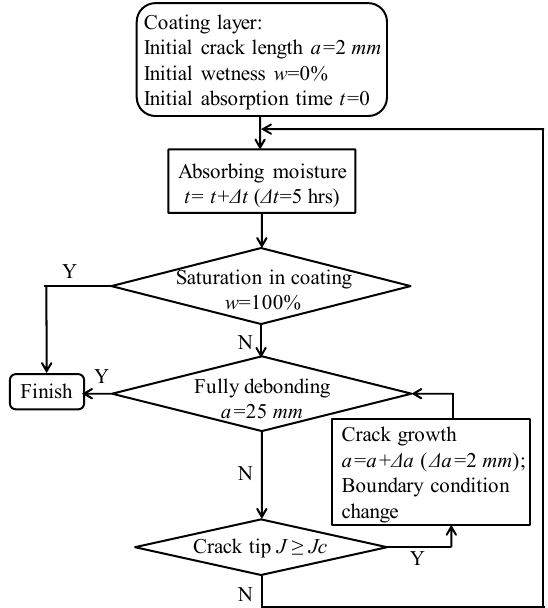
Figure 4. Flowchart of FE simulation of coating/substrate interfacial crack growth.